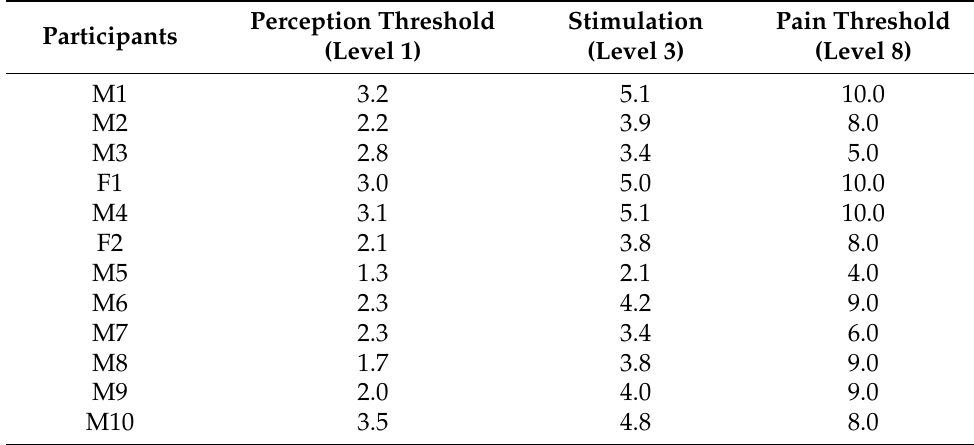
Table 1. Participants in the study and the individually-set levels of stimulation amplitude (mA) where the stimulation frequency was 50 Hz and with a pulse duration on 250 µ s. The perception threshold (Level 1) is the just-noticeable stimulation amplitude. The pain threshold (Level 8) is when the amplitude is too high for the participant to endure. The stimulation amplitude chosen for this study (Level 3) is the amplitude that was considered to provide the participant with a distinct stimulation that was also comfortable for prolonged